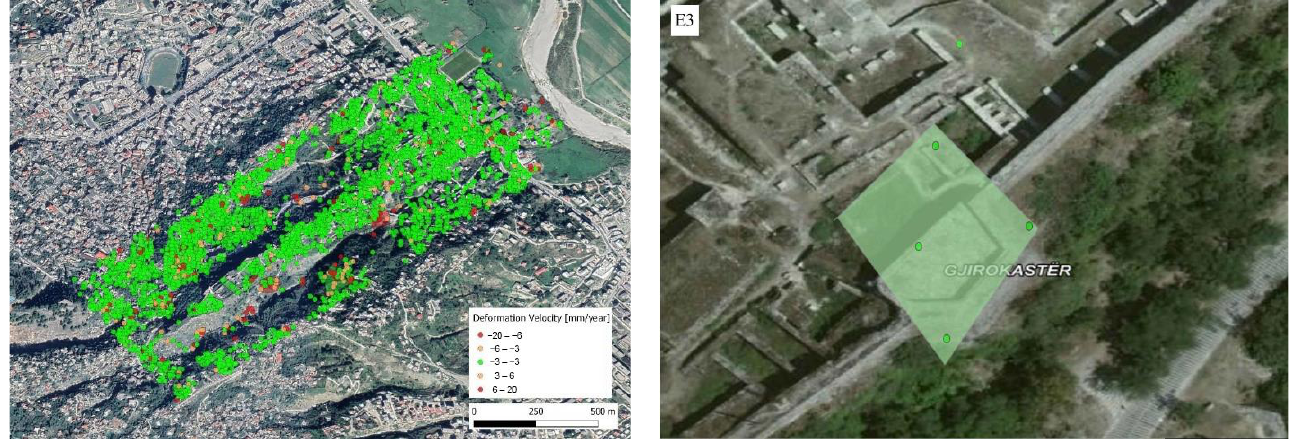
Figure 5. Deformation velocity map of the area of interest (mm/year) ( left ) and around the studied tower ( right ).